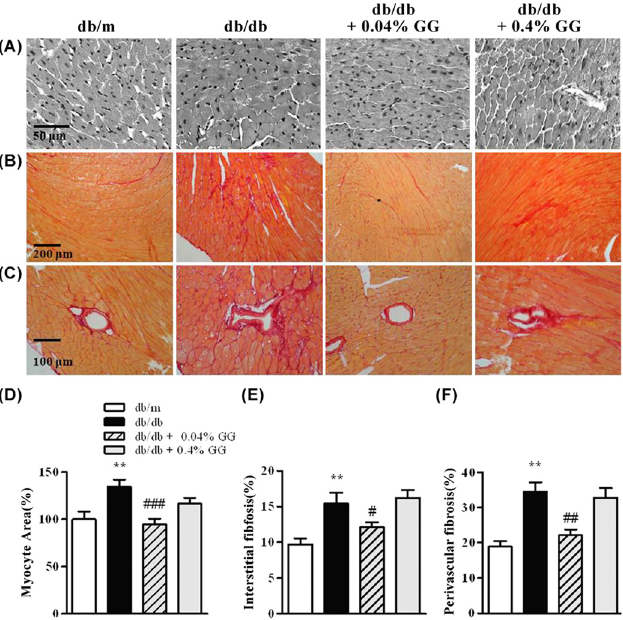
Fig 2. Gemigliptin (0.04%) attenuates myocyte hypertrophy and fibrosis in the diabetic heart. Representative images of H&E-stained cardiac tissues (A), and Sirius red-stained interstitial (B) and perivascular areas (C). Quantification of cardiomyocyte numbers in cross-sectional tissue areas (D). The proportions of interstitial (E) and perivascular (F) tissues. Data were analyzed by one-way ANOVA using Newman-Keuls post-hoc testing, and the results are expressed as means ± SEMs. ** p < 0.01 vs. db/m; #p < 0.05, ##p < 0.01, ###p < 0.001 vs.